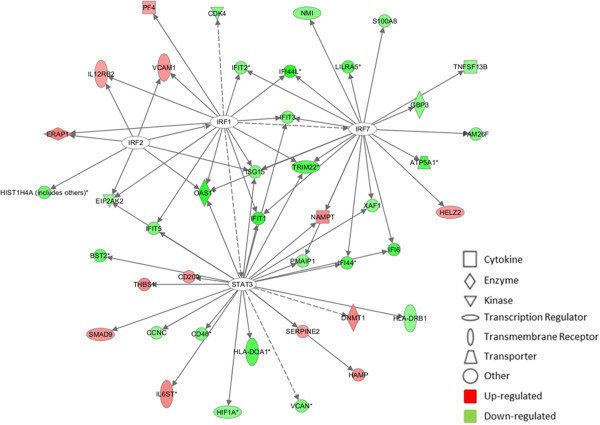
Generation of a biological network of genes related to the upstream regulator IRF2. Network was generated by IPA. Connections were applied based on known interactions within the Ingenuity Pathway Knowledge Base. Solid lines between genes represent direct interactions and the dashed lines indirect. Genes are represented by nodes, with the red and green colours indicating up- or down-regulated expression; the greater the colour intensity, the higher the level of differential expression.